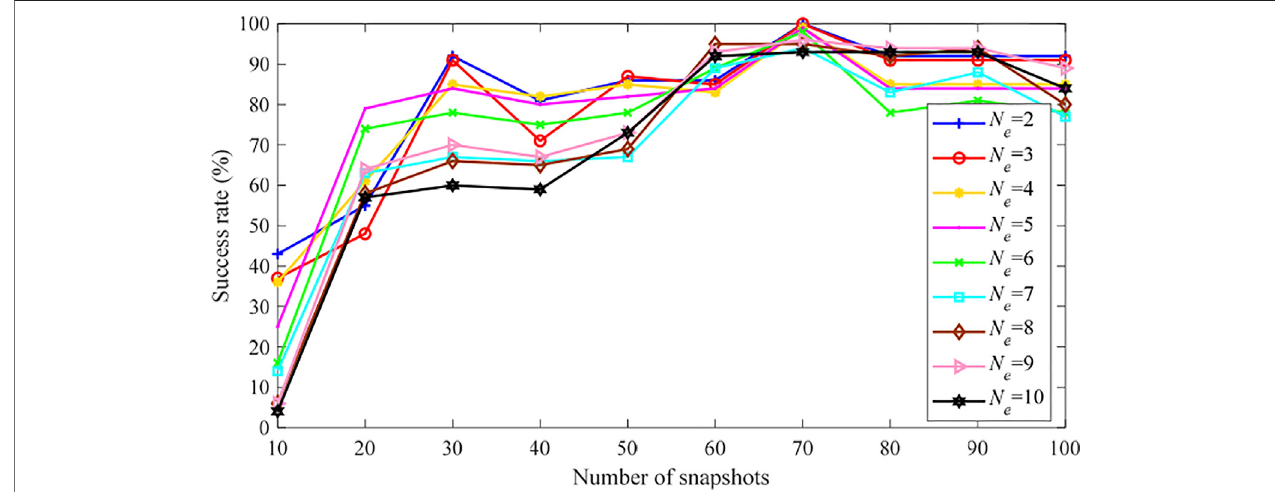
FIGURE 12 | PEI success rate of the IEEE 118-bus system using empirical MEVs (Case 1).